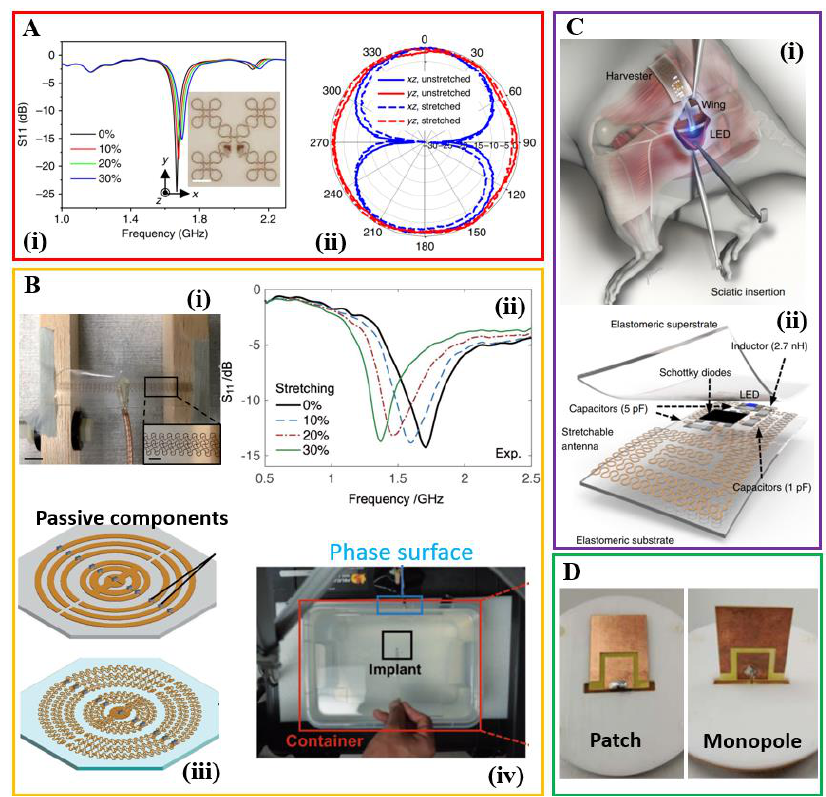
Figure 5. Cont. Figure 5.